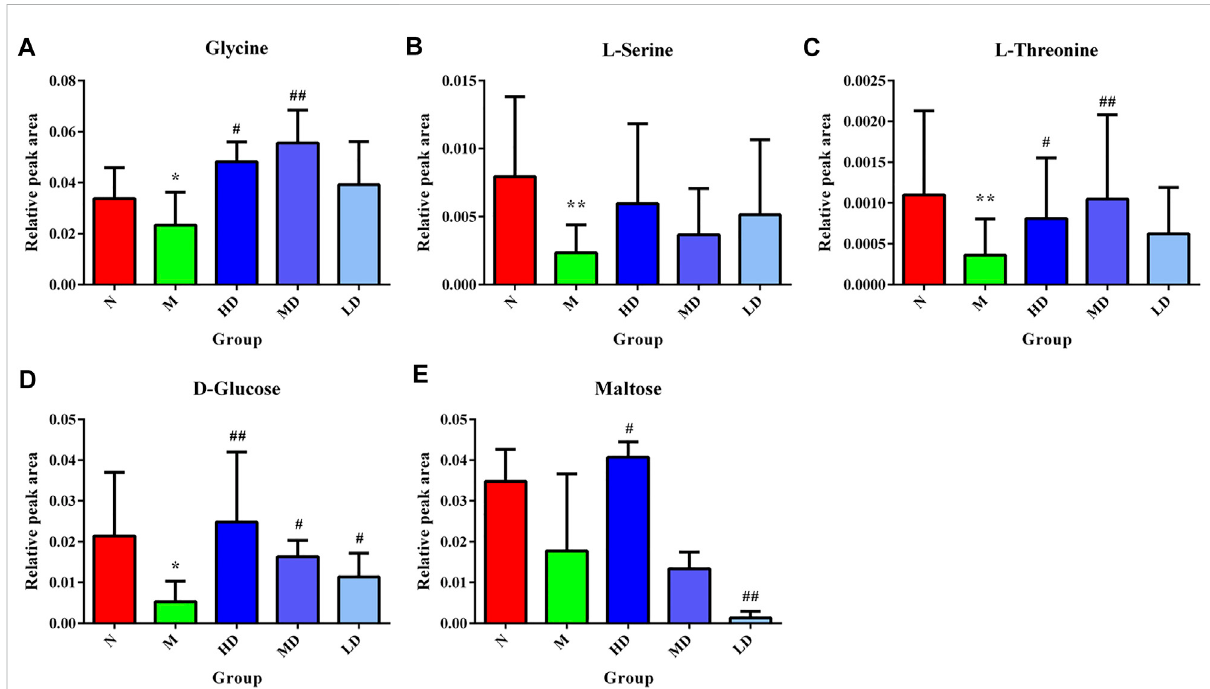
FIGURE 8 Relative content of the hepatic biomarkers in each group. (A) Glycine; (B) L -serine; (C) L -threonine; (D) D -glucose; (E) maltose. * p < 0.05, comparedwiththeNgroup;** p < 0.01,comparedwiththeNgroup; # p < 0.05,comparedwiththeMgroup; ## p <